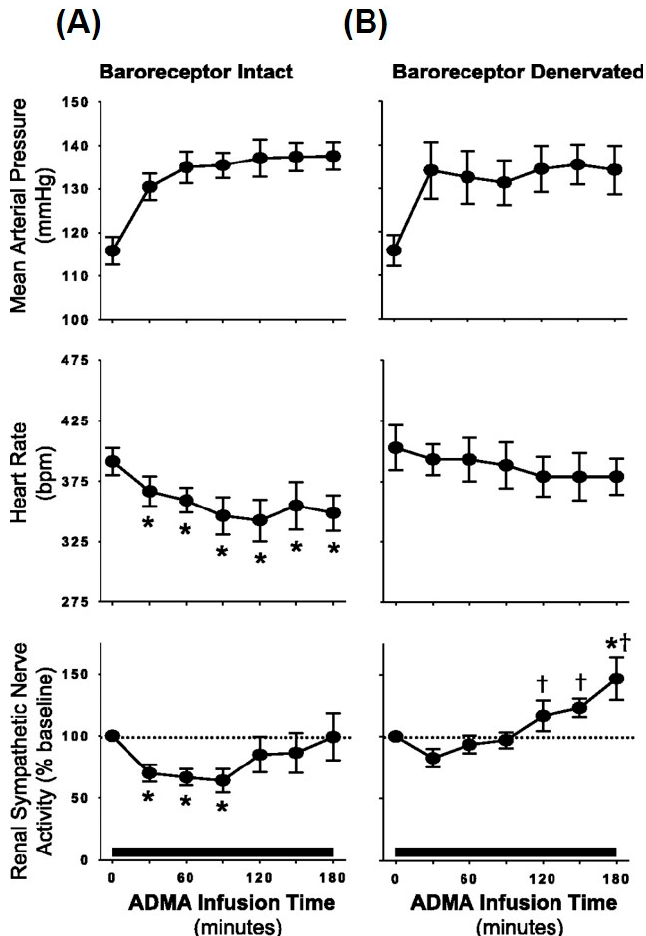
Figure 4. Average mean arterial pressure, heart rate, and renal sympathetic nerve activity during continuous systemic infusion of asymmetric dimethylarginine (ADMA; an endogenous NOS inhibitor) in baroreceptor-intact ( A ) and baroreceptor-denervated animals ( B ). In comparison with barointact animals, barodenervated animals show a significant increase in renal SNA indicating frank sympathoexcitation in response to systemic ADMA infusion. * p < 0.05 vs. baseline; † p < 0.05 vs. baroreceptor intact. (From Augutyniak et al. [87] with permission.)